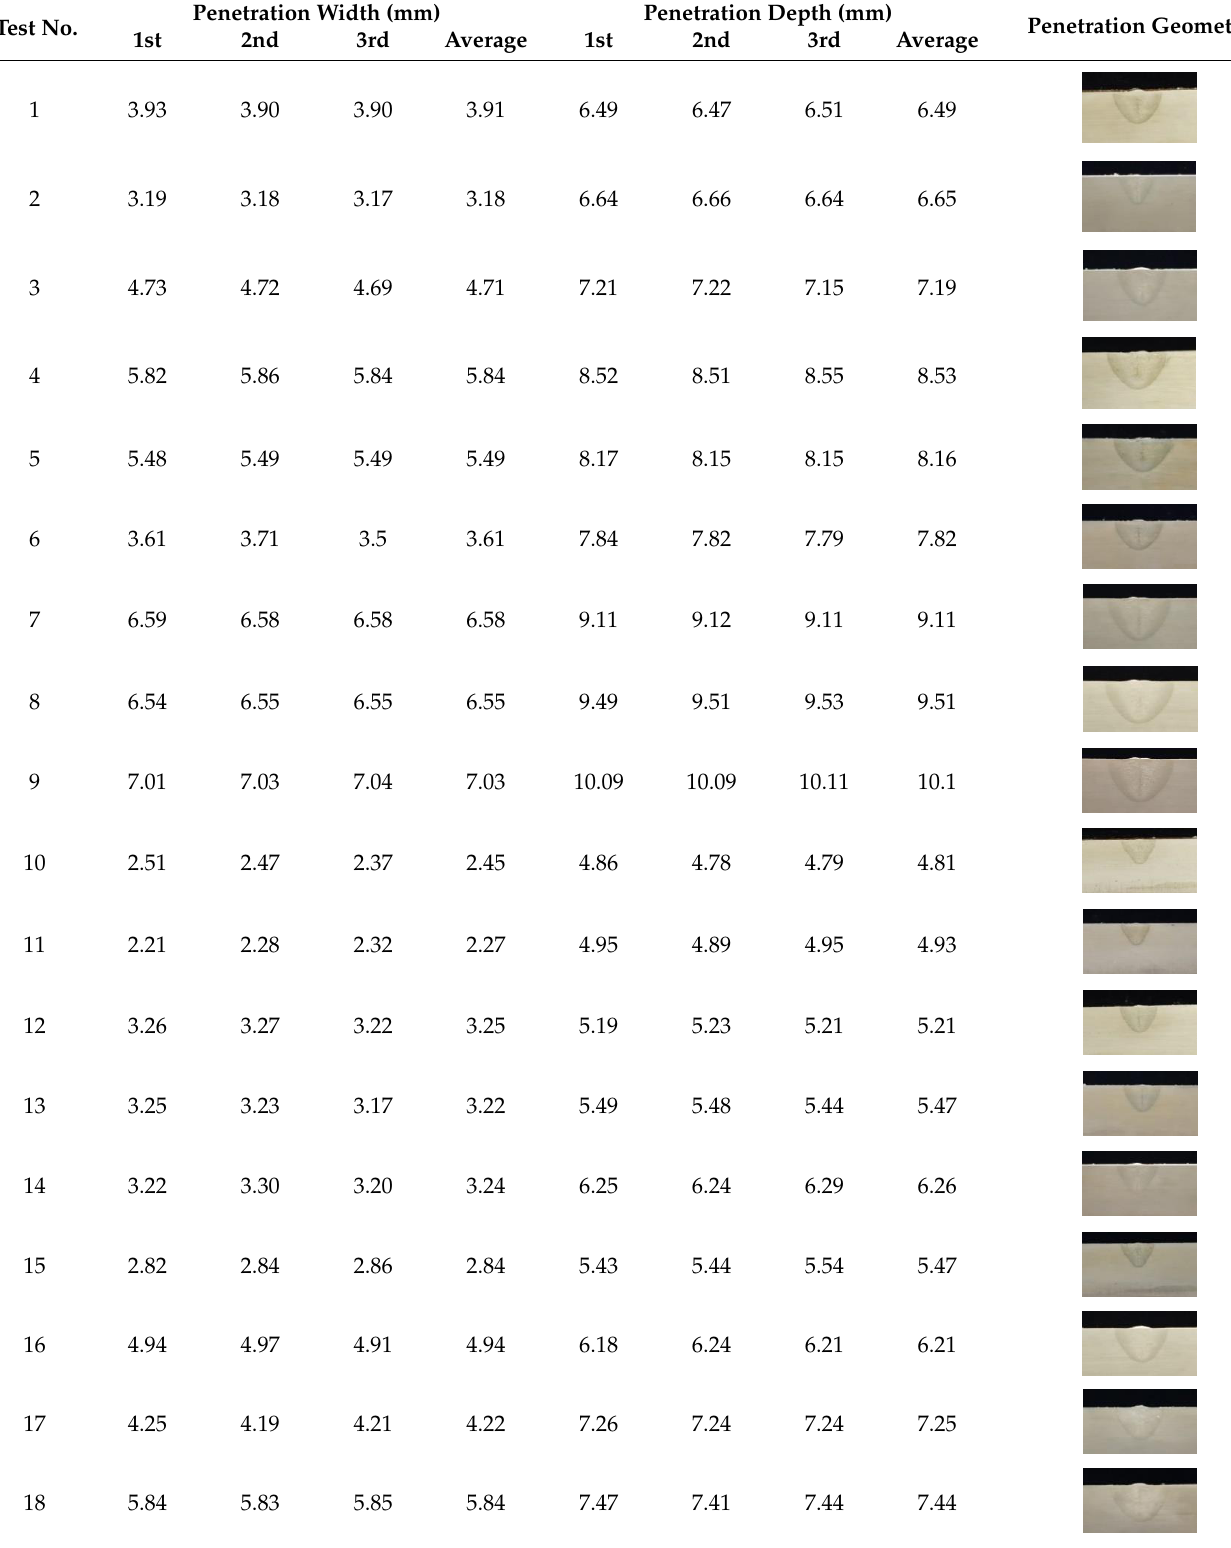
Table 4. Results of penetration geometry through welding experiment. Test No.